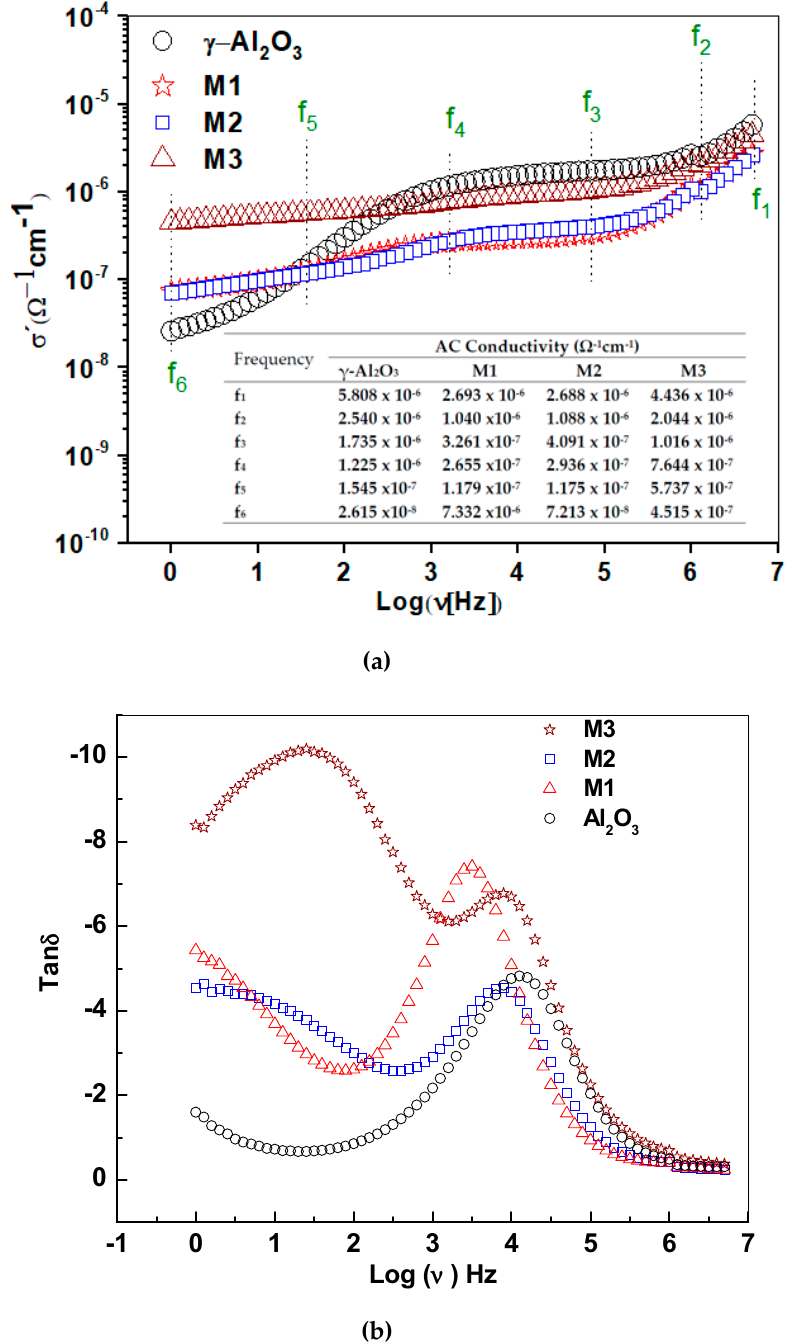
Figure 7. ( a ) Real conductivity is presented as a function of the sample frequency for alumina and the supported birnessites M1, M2 and M3. The table provides values of the conductivity at frequency f i . ( b ) Tangent plot of losses (Tan δ ) for γ -alumina and supported birnessite. Note that for M3 there is a displacement of two loss peaks, which is associated with the higher content of the birnessite material in the structure.